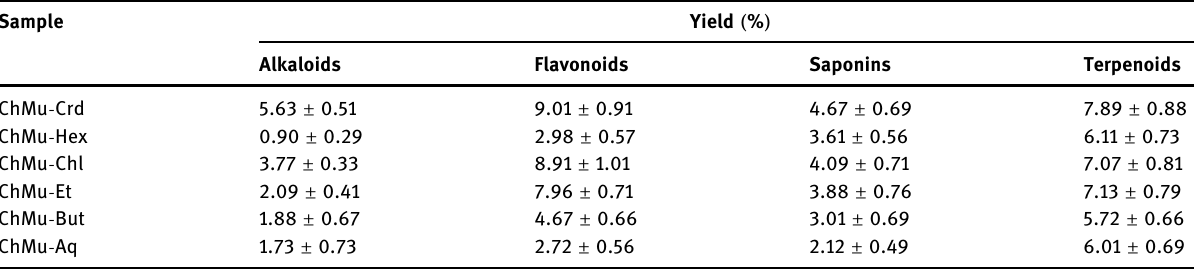
Table 3: Non - spectrophotometric quantitative phytochemical analysis of crude extract and fractions of C. murale